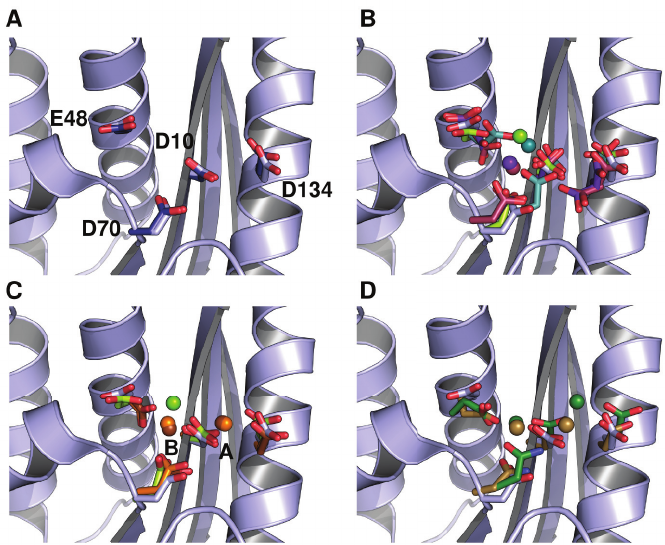
Figure 2. Conformational diversity of metal-ion interactions with ecRNH as determined by crystallography. In all cases the backbone and active-site sidechains from ecRNH in the absence of ion (PDB ID 2RN2) are shown in light blue for comparison. ( A ) Structural superposition of the four active-site residues in two structures of ecRNH in the absence of metal ions: 2RN2 (light blue) and 1RNH (dark blue). ( B ) Structural diversity of RNases H in complex with a single Mg 2+ ion: ecRNH (1RDD), green; XMRV WT (4E89), dark cyan; XMRV ∆ C (3P1G), maroon; MoMLV ∆ C (2HB5), purple. The two deletion mutants (indicated as ∆ C) bind Mg 2+ in slightly different positions than do their corresponding full-length proteins and both contain two alternate conformations for E48 and D134. ( C ) Comparison of Mg 2+ and Mn 2+ complexes: ecRNH with Mg 2+ (1RDD), green; ecRNH with Mn 2+ (1G15), orange; HIV RNase H domain with ecRNH helix C insertion with Mn 2+ (3HYF), brown. ( D ) Structural diversity of RNases H in complex with substrate: Homo sapiens RNase H with Ca 2+ ions (2QKK), brown; Bacillus halodurans RNase H with Mn 2+ ions (1ZBI), dark green.